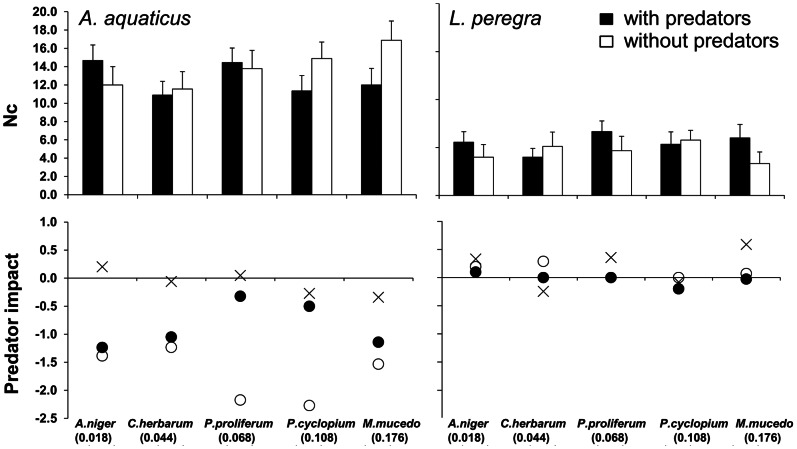
Predator impact on prey traits.Above: number of A. aquaticus and L. peregra specimens per gram of leaf litter (Nc) in leaf bags conditioned with one of five fungal strains, with predators (black bars) and without predators (white bars); below: predator impact on prey density (crosses), movement (•, based on percentage of prey labelled with 32P) and Activity Density (○). Numbers in parentheses on abscissa indicate Activity Density (µCi/g) of leaf bags conditioned with different fungus strains.